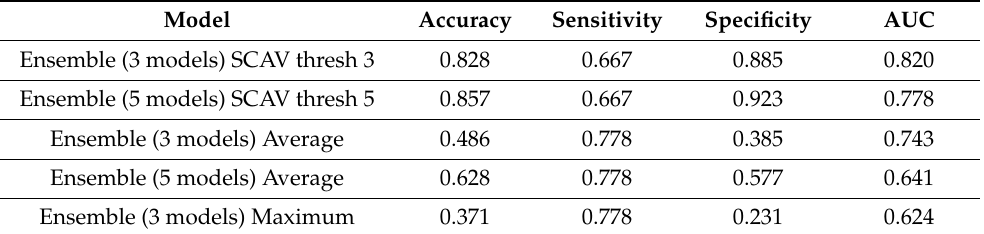
Table 8. EGFR mutation best results on Test dataset, ensembles of CNNs.